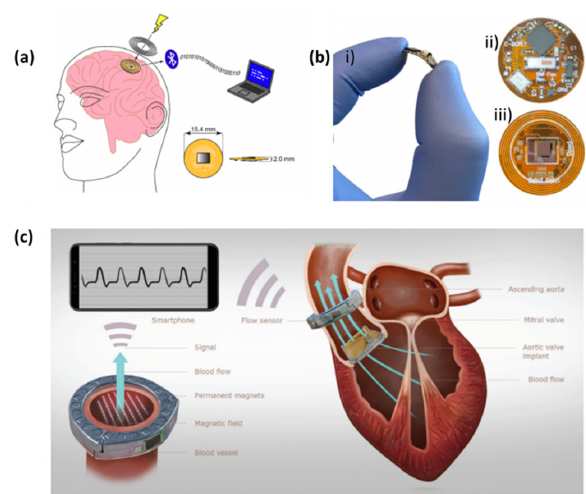
Figure 7. Data transmission strategies for implantable biosensors. ( a ) The implantable sensor small size is achieved by the use of wireless power transfer provided by an external coil and the flexible substrate. The device transmits data via a low energy Bluetooth link to a receiving device; ( b ) Photos of the implantable neural interface: (i) the neural interface being flexed by a hand, (ii) the top side of the neural interface, (iii) the bottom side of the neural interface [131] and ( c ) illustration of the heart valve monitoring system, which communicates the data by wireless [132].